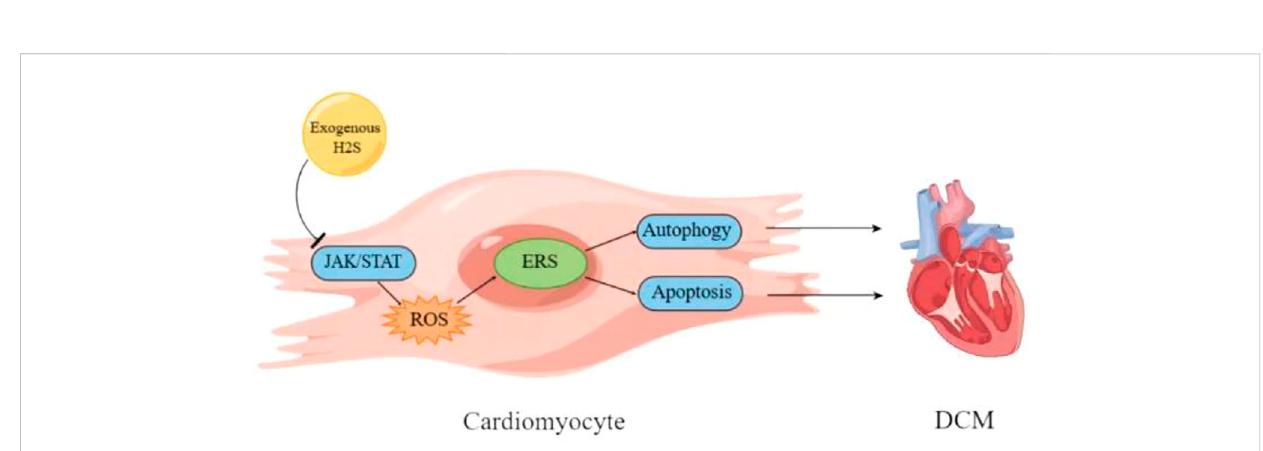
FIGURE 3 Schematic diagram of mechanism of exogenous H 2 S improving diabetes cardiomyopathy. DCM, diabetes cardiomyopathy; ERS, endoplasmic reticulum stress; JAK/STAT, janus kinase/signal transducer and activator of transcription.